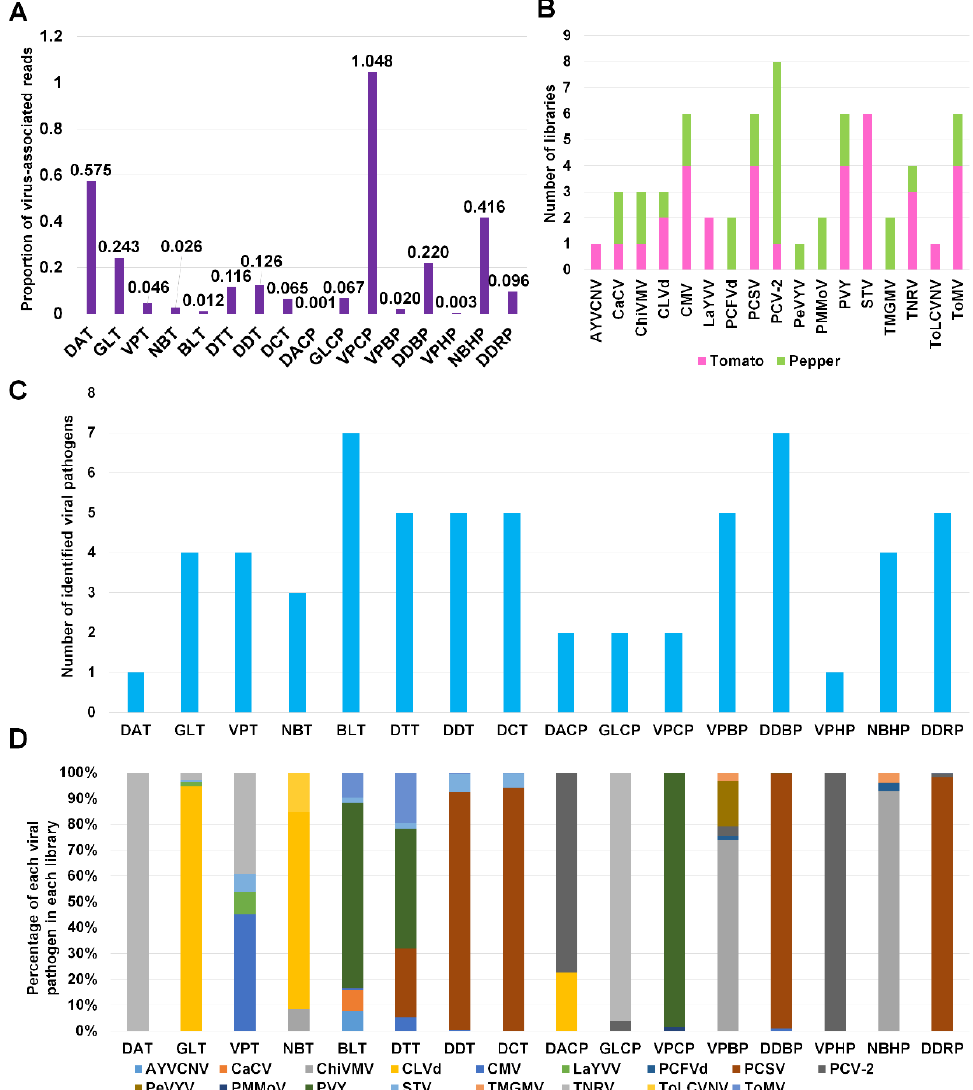
Figure 4. The viral population of identified viral pathogens in each library. ( A ) The proportion of virus-associated reads in each library. ( B ) The frequency of identified viral pathogens in different tomato and pepper libraries. Purple- and green-colored bars indicate the number of libraries for tomato and pepper plants, respectively, in which viral pathogens were infected. ( C ) The number of identified virus and viroid species in each library. ( D ) The viral population of identified viral pathogens in each library based on the number of virus-associated reads.